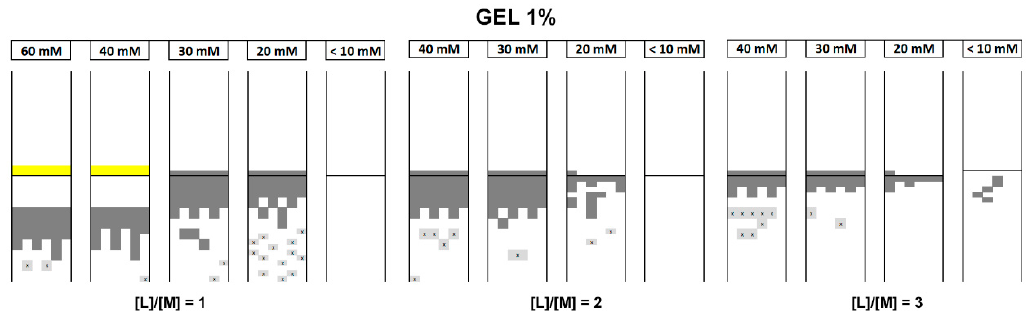
Figure 6. Results of the crystallization screening performed by using the two layers-gel technique in water for CdCl 2 -bpp. This representation shows the stability regions of the different species as a function of the starting total [L] + [M] reactant concentrations and [L]/[M] ratio (M = Cd 2+ ; L = bpp), as well as also the phases distribution along the tube. Yellow = 3D- sra phase (thin needles); dark grey = 1D- cha phase (big dendritic “fern-leaf” shape); light grey − (x) = bladed or radial aggregates of platy 1D- cha crystals.